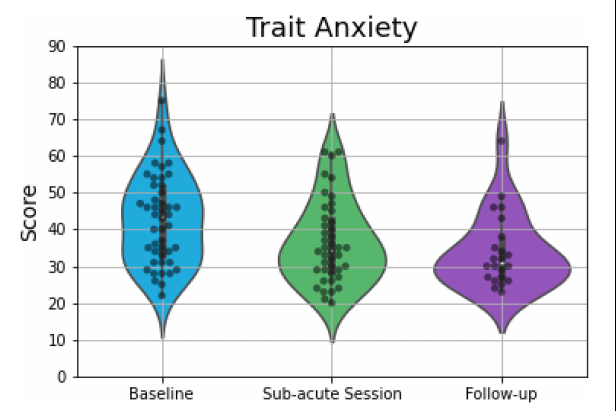
FIGURE 3 | Violin plots displaying scores on measures of trait anxiety, which demonstrated significant differences between baseline and the other two time points. The plot consists of median (SE) ratings of trait anxiety before, 1-day after and 7-days after psilocybin truffles. The thick line indicates the interquartile range, whereas the white dot indicates the median. Each gray dot indicates a data point, whereas the density is scaled to the relative count across all bins. Wider sections of the violin plot represent a higher probability of observations of a given